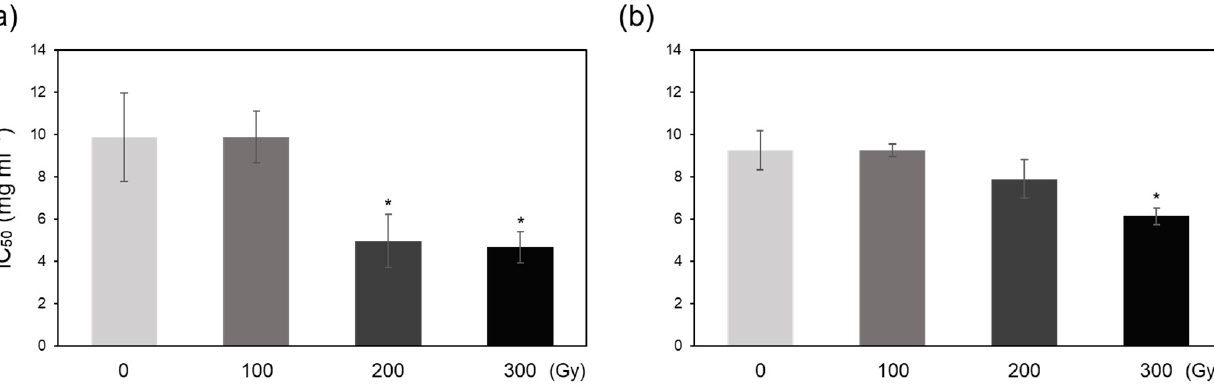
Figure 4. Estimation of superoxide radical (O 2 •− ) scavenging activity in gamma-irradiated rice plants by measuring half maximal inhibitory concentration (IC 50 ) values. ( a , b ) IC 50 values of plants subjected to acute ( a ) and chronic ( b ) gamma irradiation. Data represent mean ± SD. Asterisks indicate significant differences between control (0 Gy) and other treatments (* p < 0.05).